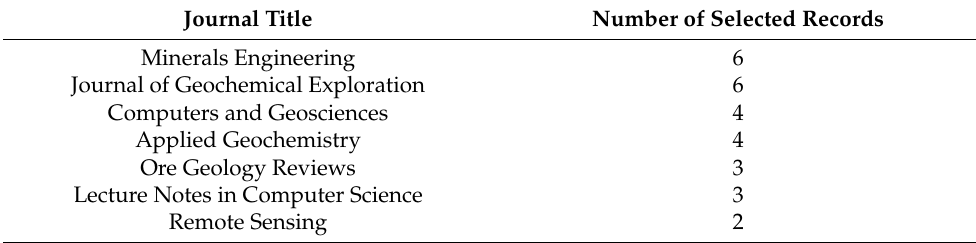
Figure 3. Share of the topics excluded from the review in the last stage of the selection process. Title of the journals with more than one record in the list of selected records are provided in Table 1. Table 1. Title of journals with more than one entry in the final list.